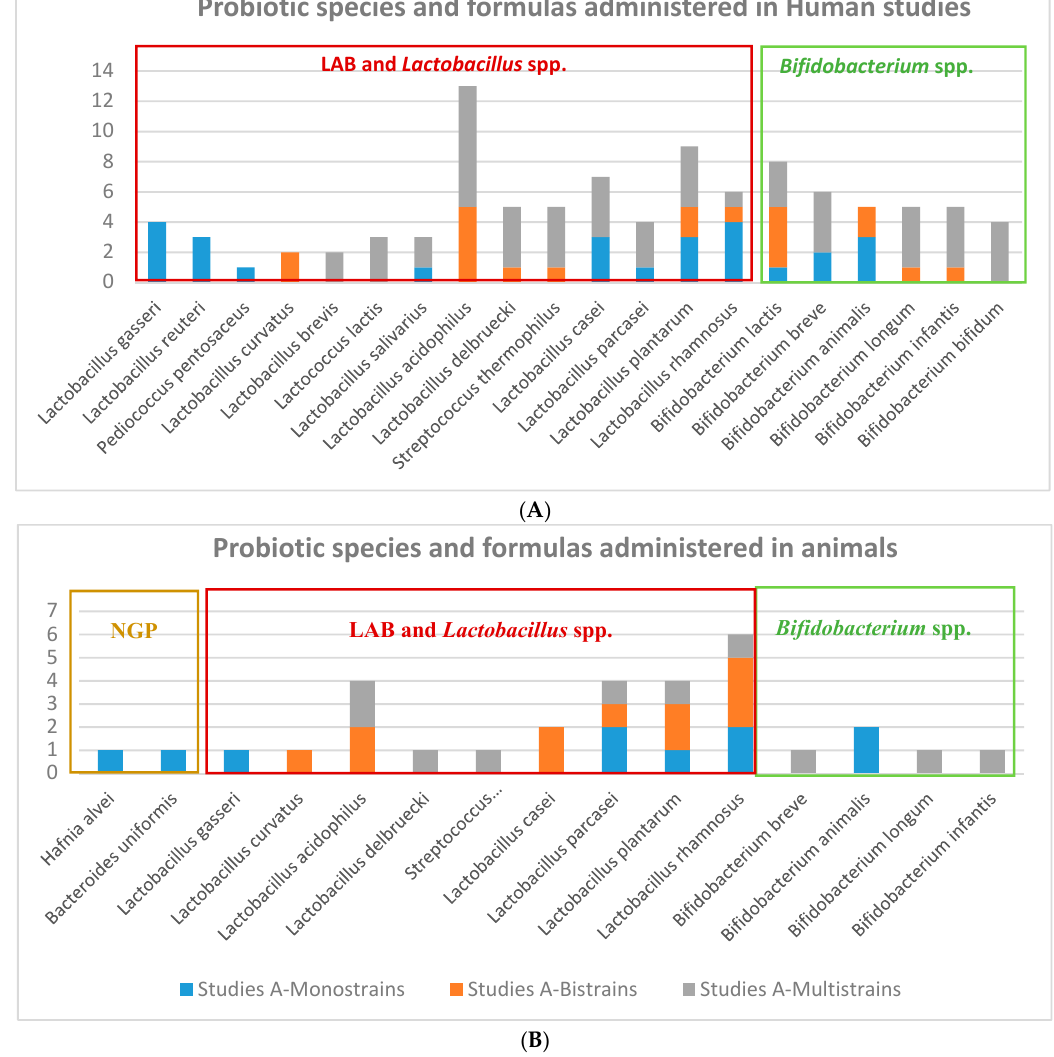
Figure 2. Probiotics formula administered in interventional obesity-related diseases in ( A ) humans ( B ) animal clinical studies.